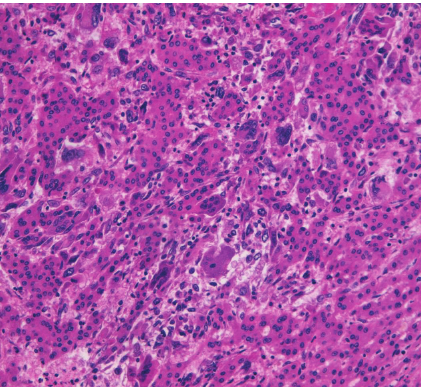
Figure 1: Hepatocellular carcinomatoid cells mixed with osteoclast- like giant cells (H&E,